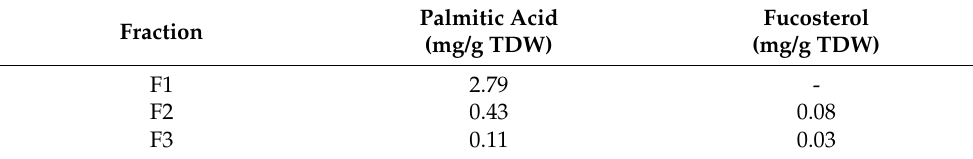
Table 5. Quantification of palmitic acid and fucosterol by GC-MS in each fraction.